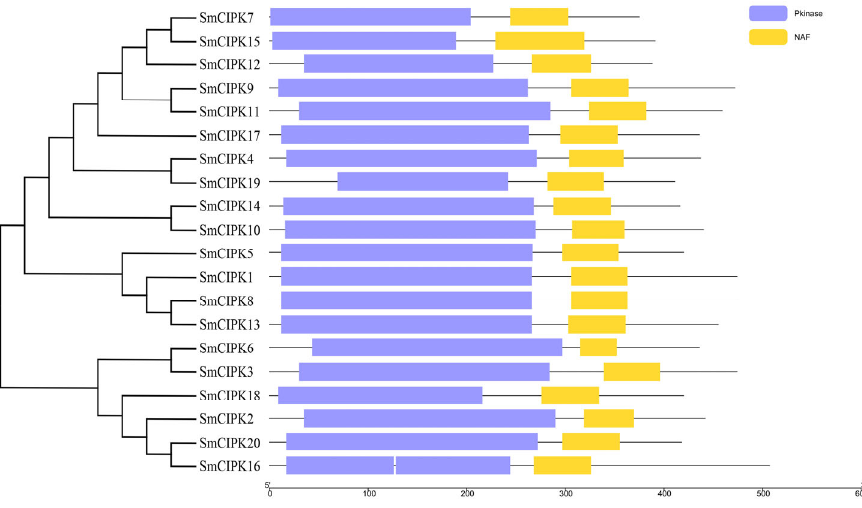
Figure 3. Structure of Pkinase domain or NAF domain of SmCIPKs.